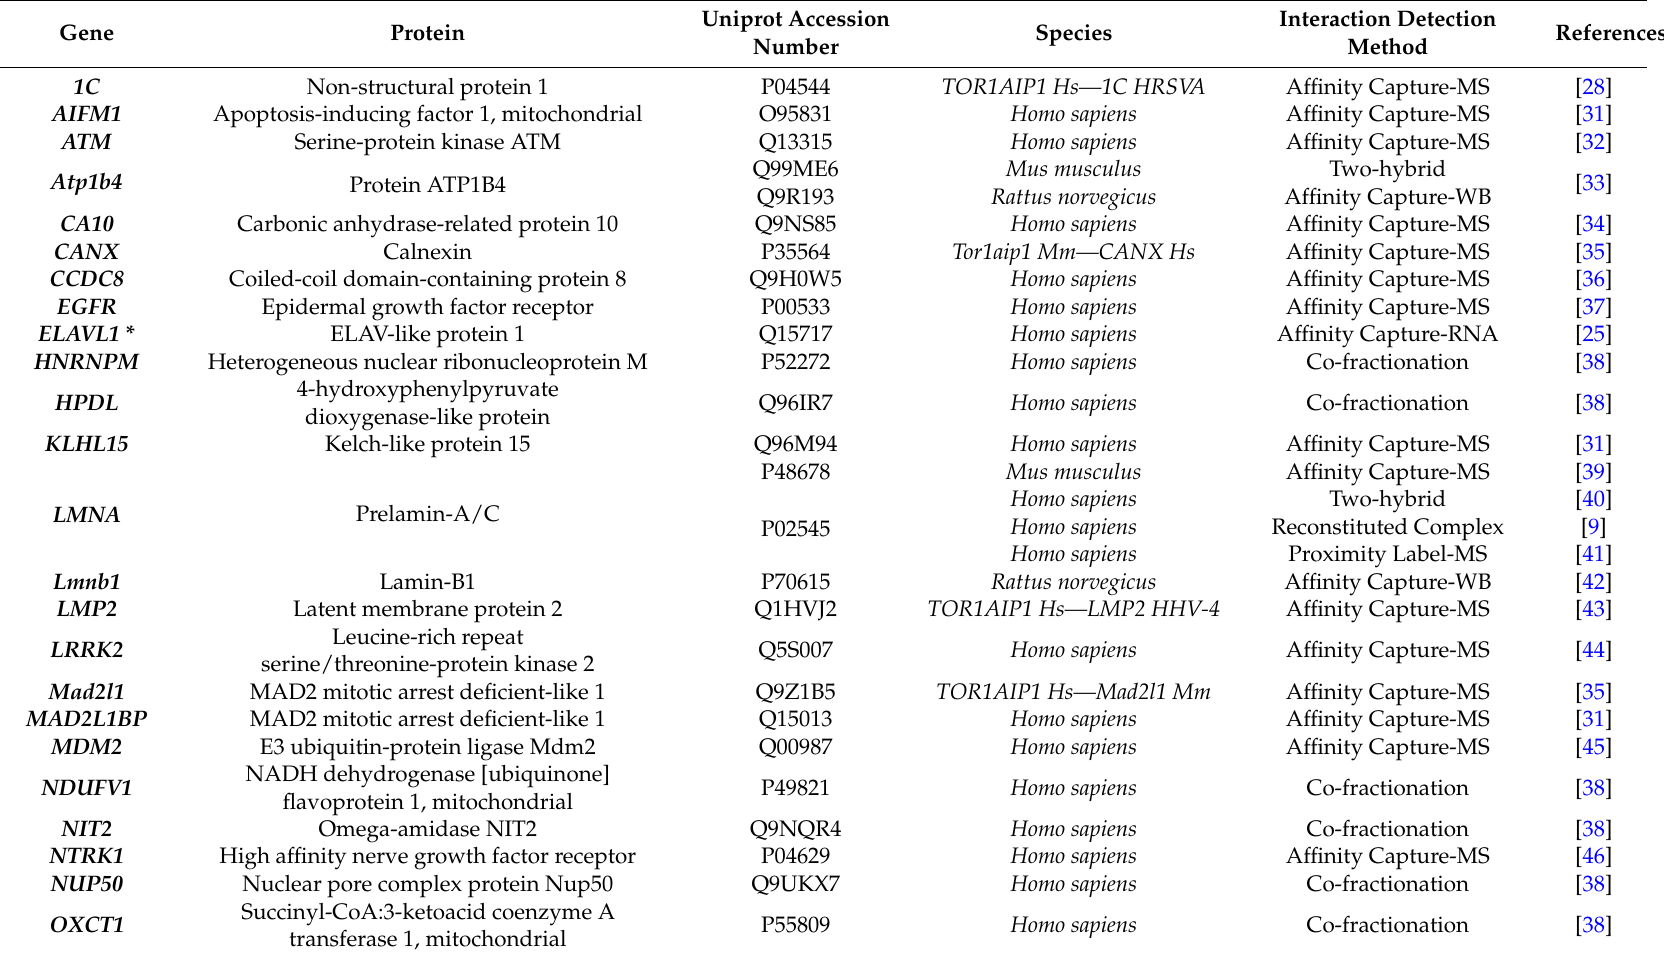
Table 1. LAP1 interactors obtained from online databases after validating curated interactions via consulting respective